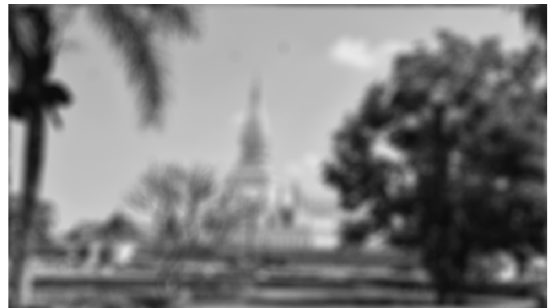
Figure 11. Three degraded grey image by blurred matrices A 1 , A 2 , and A 3 , respectively.